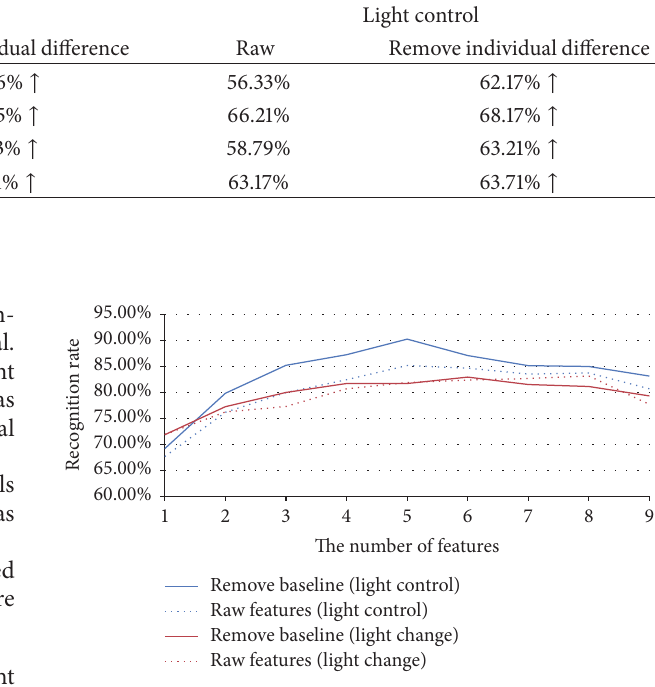
Figure 7: The recognition rates under different features’